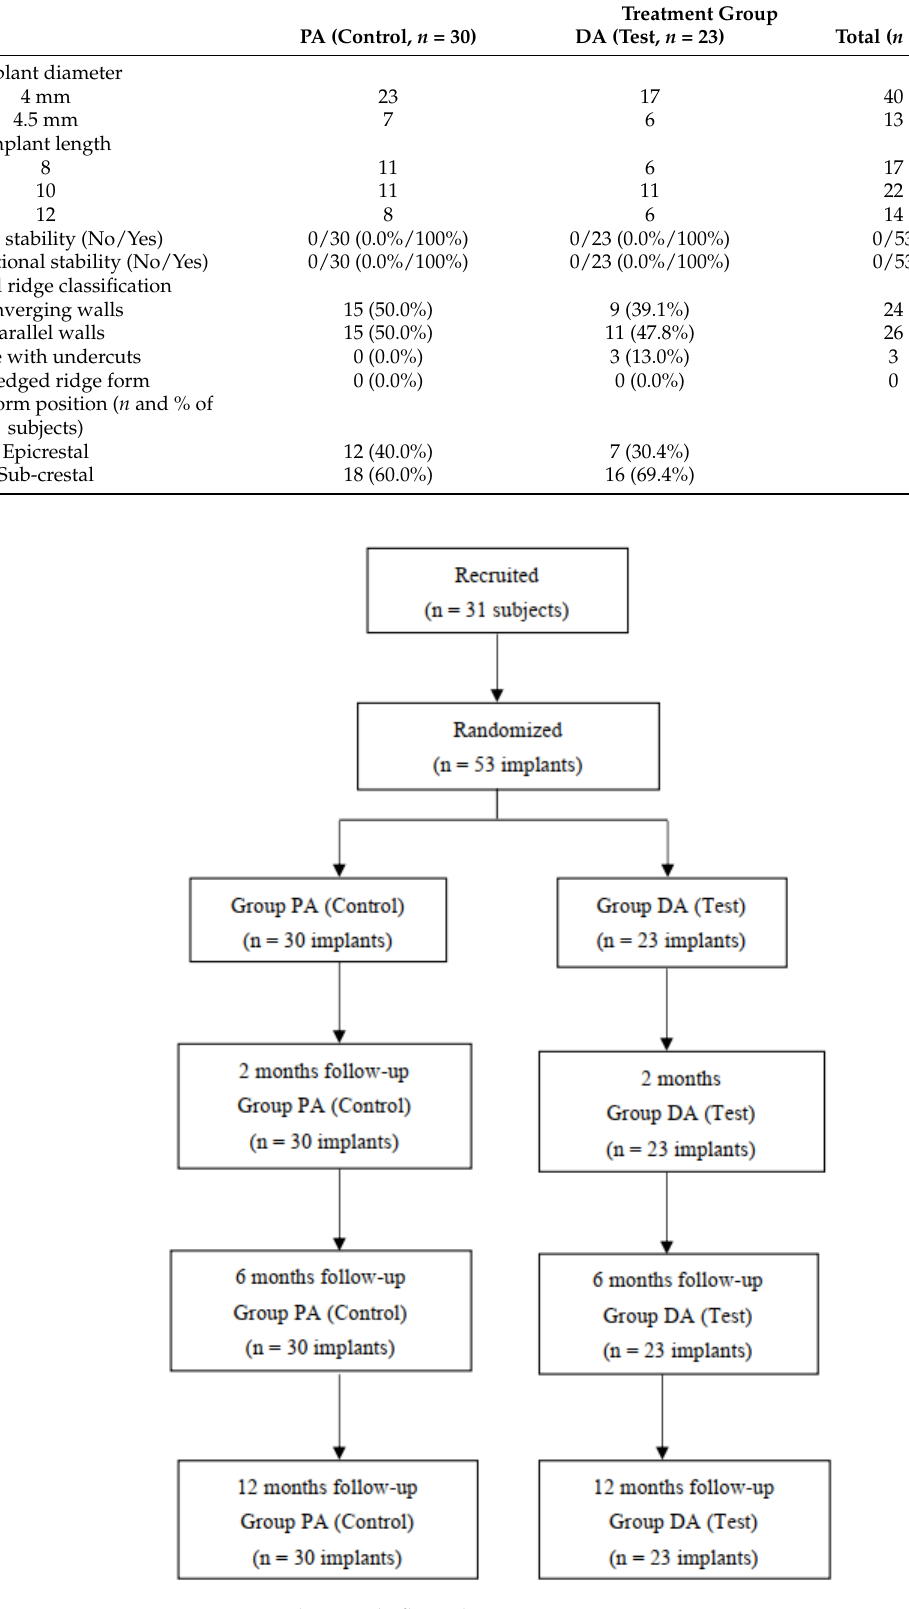
Figure 5. Study sample flow-chart . Table 1. Baseline demographic characteristics of the study sample.